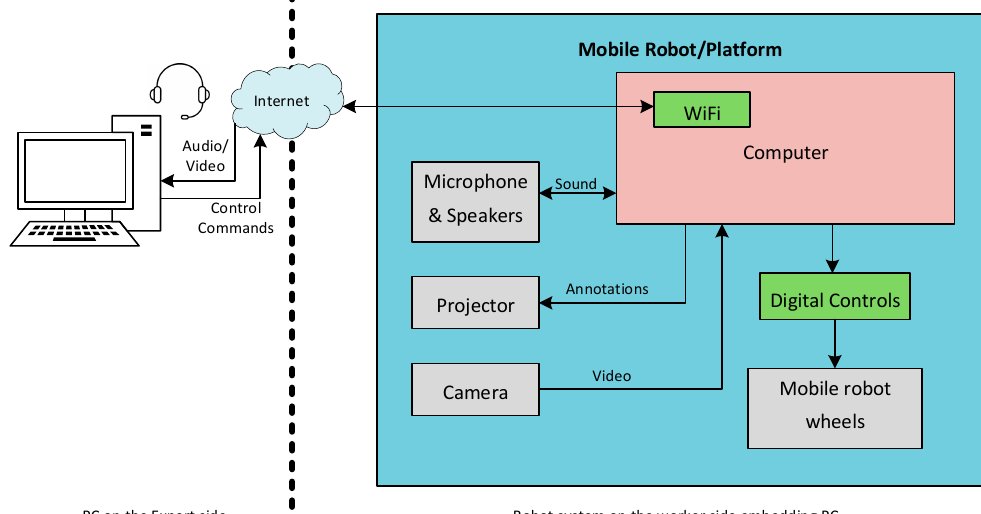
Figure 4. System architecture diagram for ExpertOnWheels